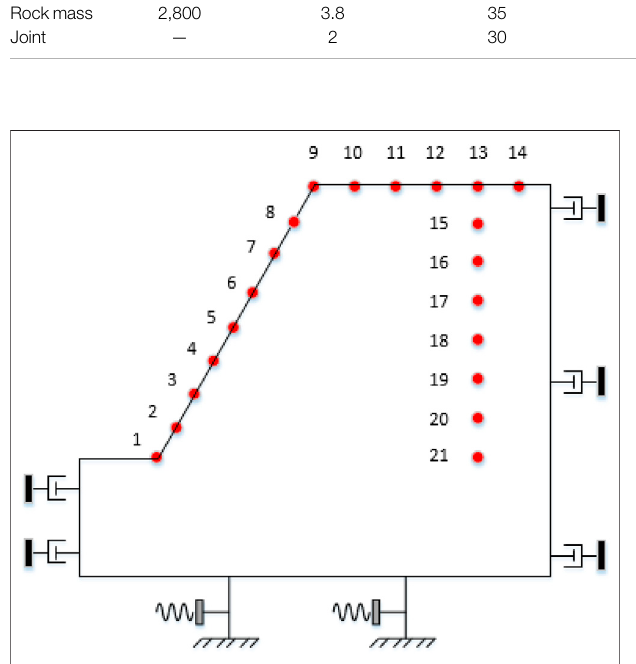
FIGURE 1 | Diagram of the model and monitoring points of slope.